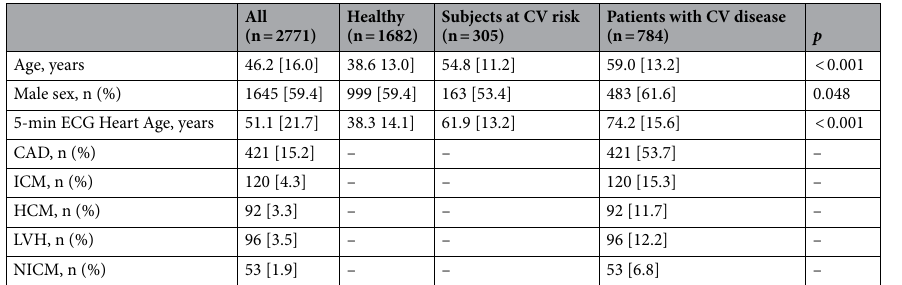
Table 1. Baseline characteristics. Age and 5-min ECG Heart Age are presented as mean (standard deviation). CAD: coronary artery disease; ICM: ischemic cardiomyopathy; HCM: hypertrophic cardiomyopathy; LVH: left ventricular hypertrophy; NICM: non-ischemic cardiomyopathy.